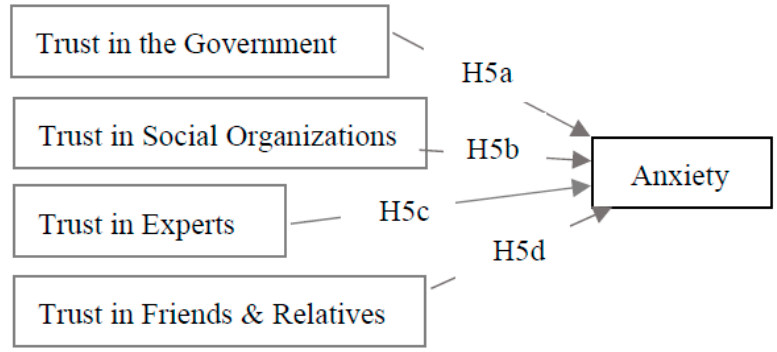
Figure 2. Schematic illustration of the research model